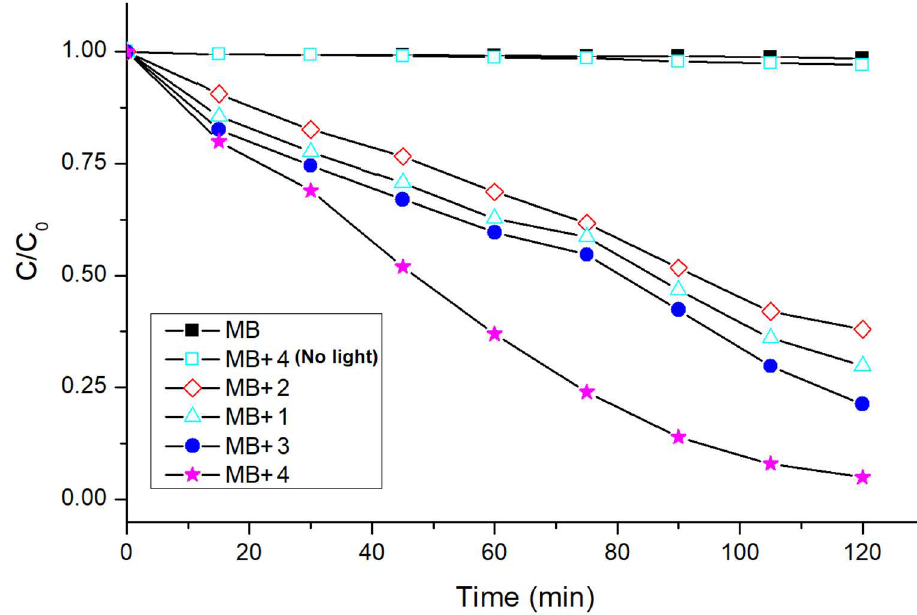
Figure 4. Photocatalytic degradation of methylene blue (MB) under visible light irradiation by different morphologies of Sn(IV) porphyrin-based nano-aggregates.